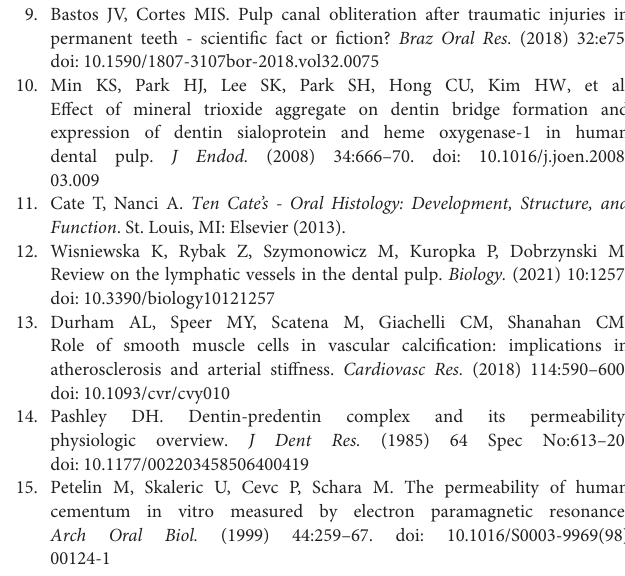
Supplementary Figure S1 | Immunostains for OCN, OPN, BSP, and OSX in unmineralized pulp. Supplementary Movie S1 | Movie illustrates pulp from three patients. Left to right illustrate low (control), medium, and high mineral densities of pulp, along with dentin and cementum